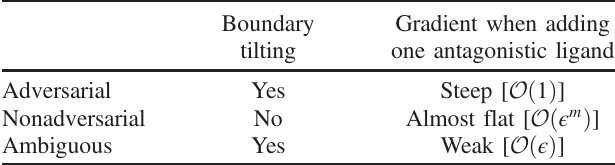
TABLE I. Categories of